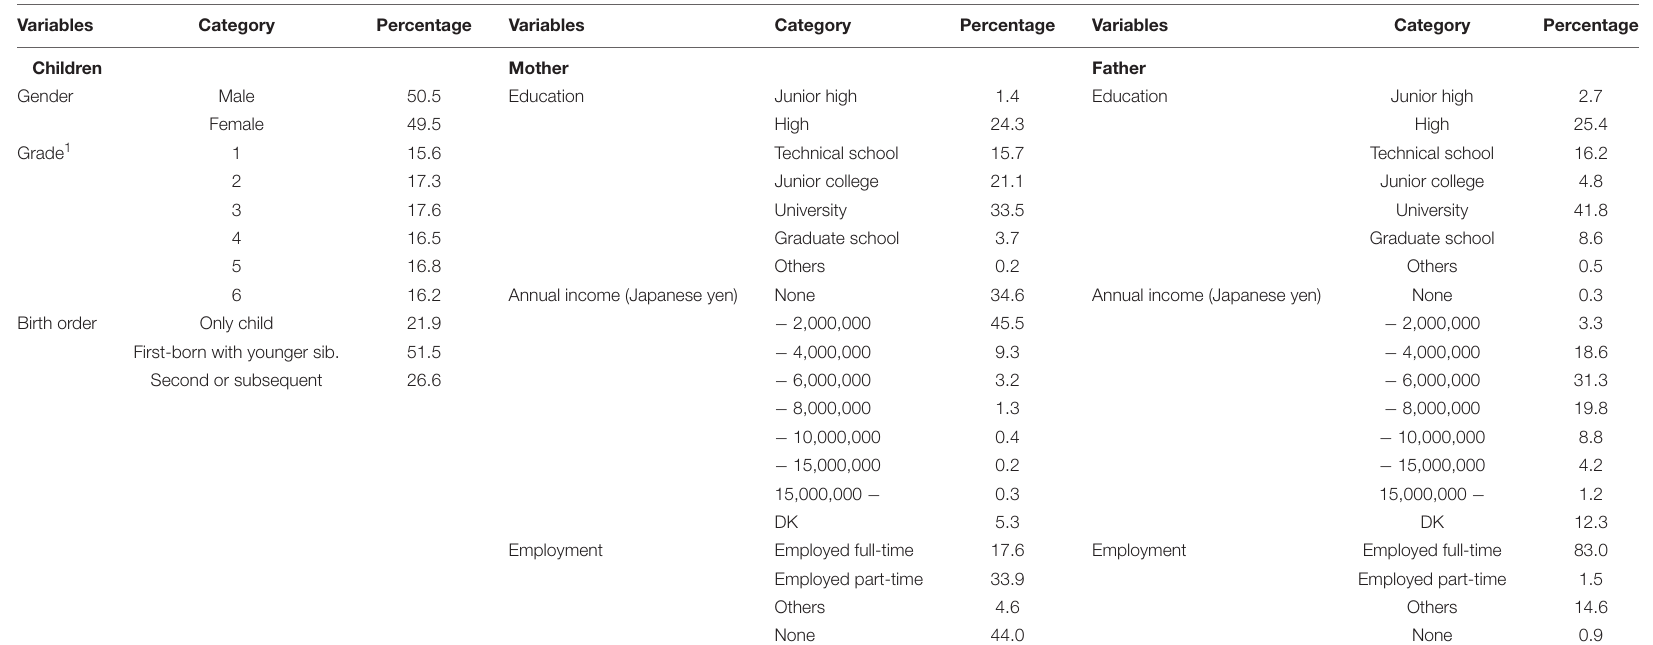
TABLE 1 | Demographic description of the sample. Variables Category Percentage Variables Category Percentage Variables Category